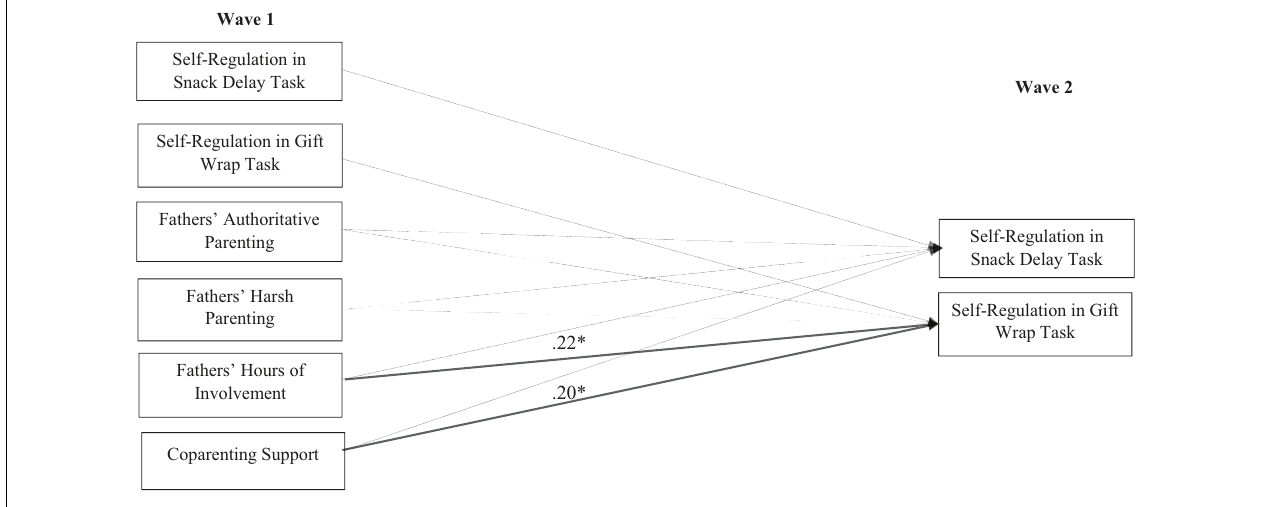
FIGURE 2 | Associations between non-resident fathers’ parenting, coparenting, and children’s self-regulation at Wave 1 and Wave 2. Child age, mothers’ parenting (i.e., authoritative and harsh), child gender, and father education level were included as control variables but (to more effectively show associations among paths of interest) were not included in the above figure. Statistically significant estimates are depicted in solid bold lines. Dotted lines indicate estimates that were not statistically significant. χ 2 (29) = 34.15, p = 0.23; CFI = 0.950; RMSEA = 0.038; ∗ p <